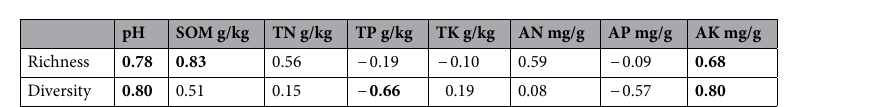
Table 1. The correlations of soil fungal richness and diversity with soil properties in karst rocky desertification regions. Pearson correlation analysis was used to determine the relationships of richness (Ace) and diversity (Shannon) with soil properties in karst rocky desertification regions. Values in bold are significantly different, P < 0.05. Soil organic matter (SOM), total and available nitrogen (TN and AN), total and available phosphorus (TP and AP), and total and available potassium (TK and